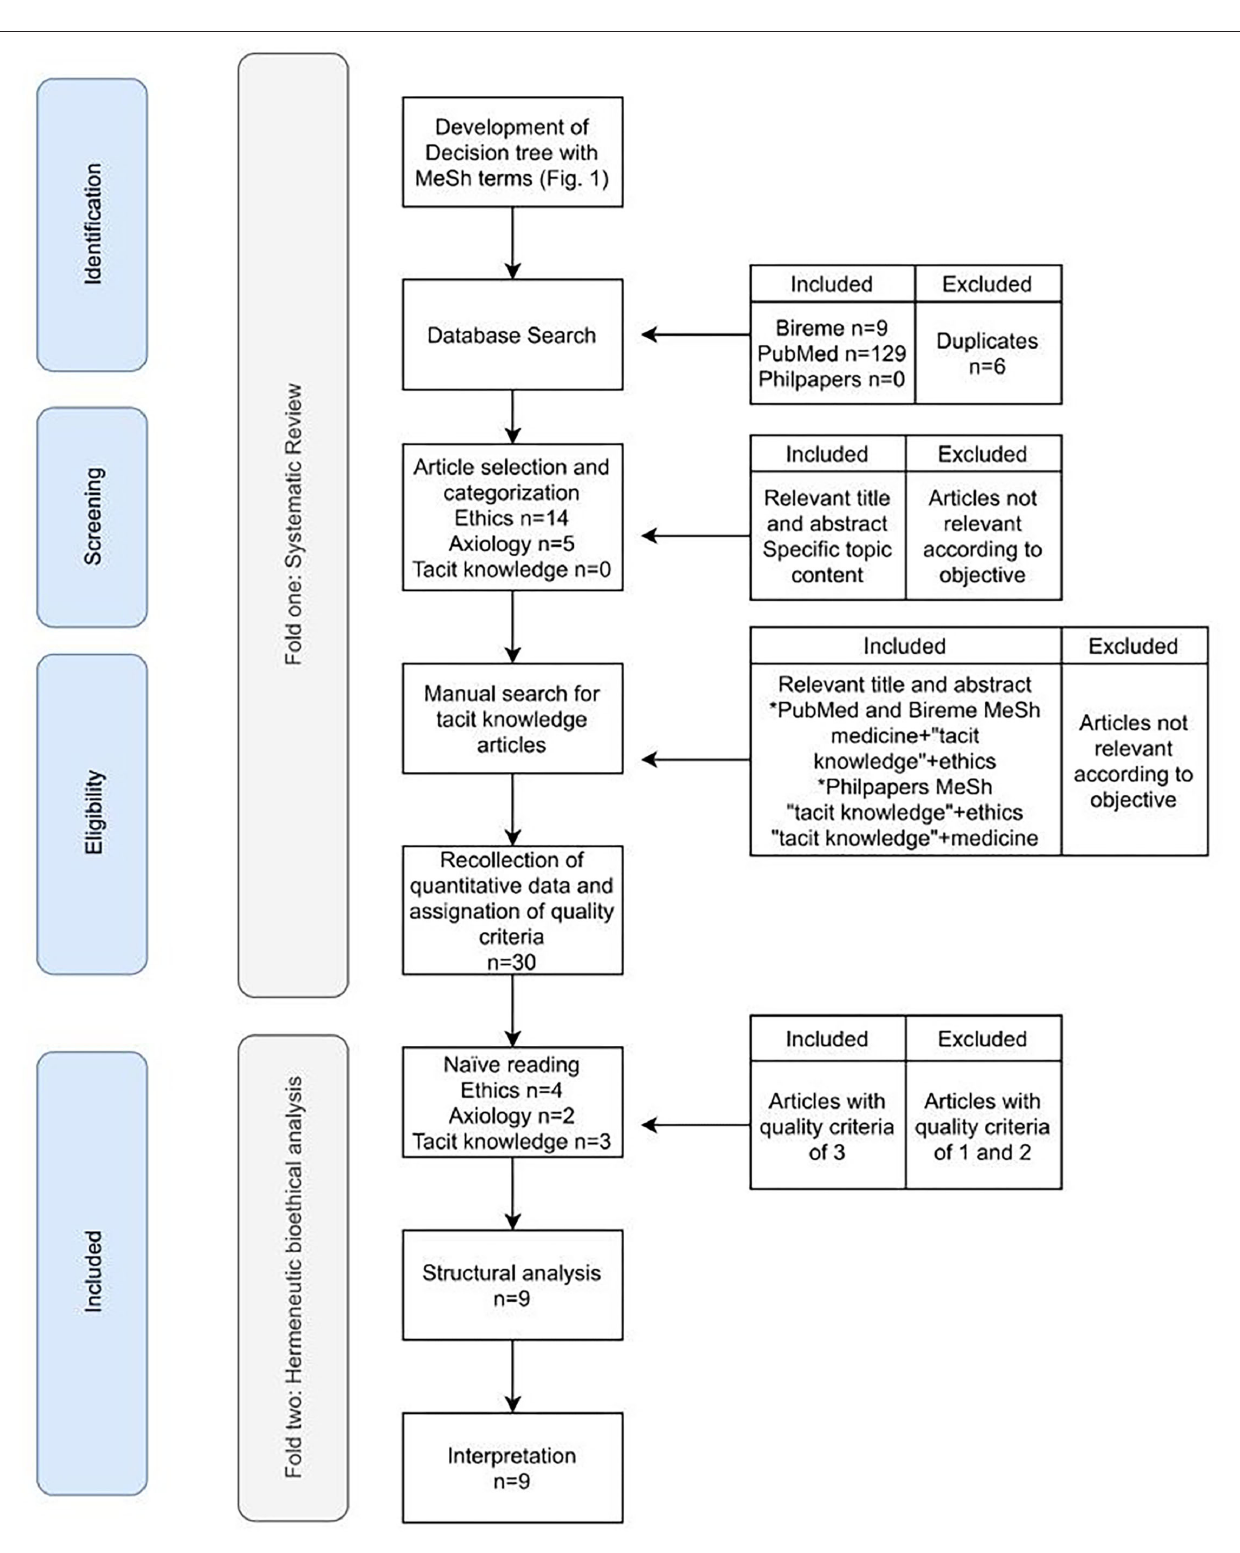
FIGURE 2 | Fold One and Fold Two Flowchart according to